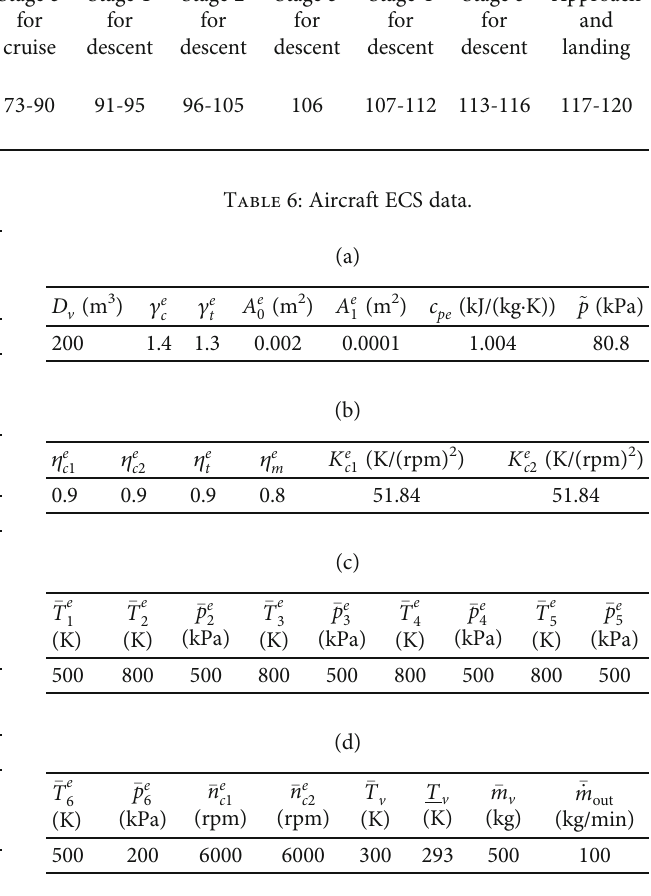
Table 7: Heat energy generated within the vessel.